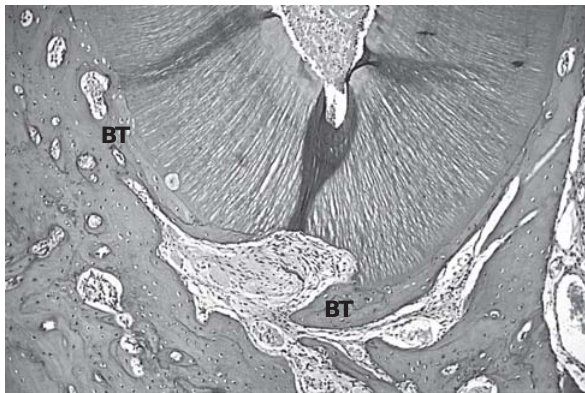
FIGURE 4- Group I. Bone tissue (BT) covering almost completely the lingual root surface. Hematoxylin-eosin (original magnification X63)